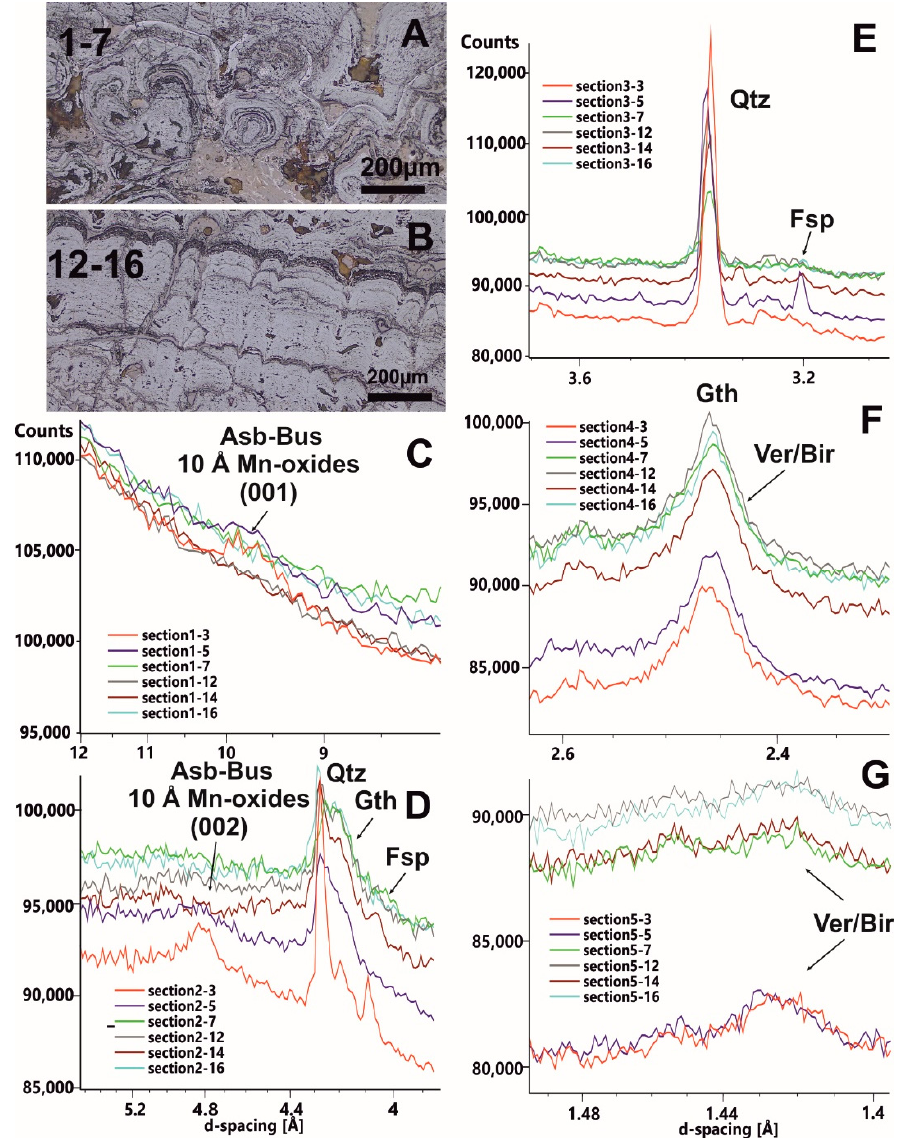
Figure 6. ( A , B ) optical microscope image of areas belonging to the analyzed regions of the sample. Micro-XRD cross analysis made on crust DR07-9 in the selected from the top to 24 mm, d-spacing ( C , D ) 12–8 Å and 5.3–3.9 Å, in which it is possible to recognize the (001) and (002) reflection of asbolane/buserite in Sections 2–3 and 2–5; ( E ) 3.7–3 Å, Qtz and Fsp reflections; ( F , G ) 2.65–2.3 Å and